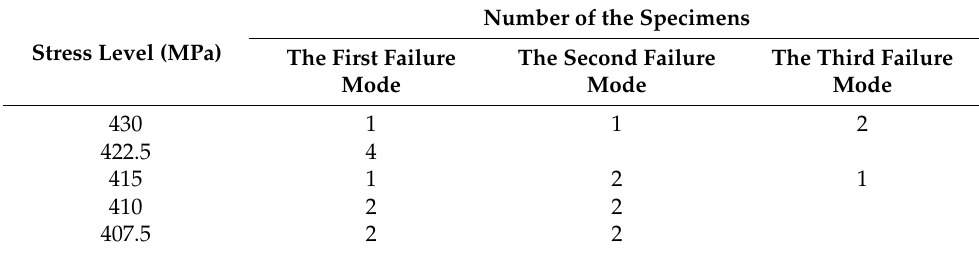
Table 4. The number of specimens HCF-HR-HBS for each failure mode. Number of the Specimens Stress Level (MPa) The First Failure